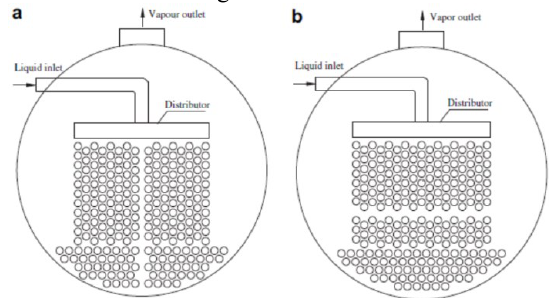
Fig. 1. Tube arrangements in a spray evaporator, investigated in the study by Yang and Wang [14]; a) evaporator tubes arranged in neighbouring rows (aligned next to each other), b) form the bottom to the top.